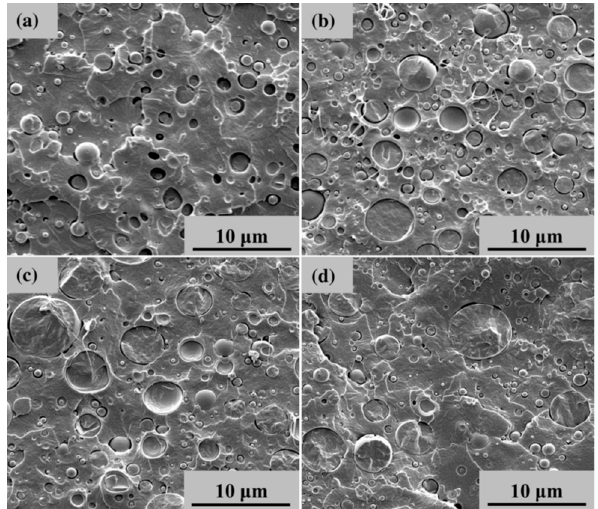
Figure 3. SEM images of PLA/PBS blends at different PBS contents ( a ) 10 wt%, ( b ) 20 wt%, ( c ) 30 wt%, and ( d ) 40 wt% with particle diameters from 0.2 to 6.5 µm [35]. Reprinted by permission from Springer Nature: Polymer Bulletin, Accelerated hydrolytic degradation of poly(lactic acid) achieved by adding poly(butylene succinate), Wang, Y.-P.; Xiao, Y.-J.; Duan, J.; Yang, J.-H.; Wang, Y.; Zhang, C.-L., Copyright © Springer-Verlag Berlin Heidelberg